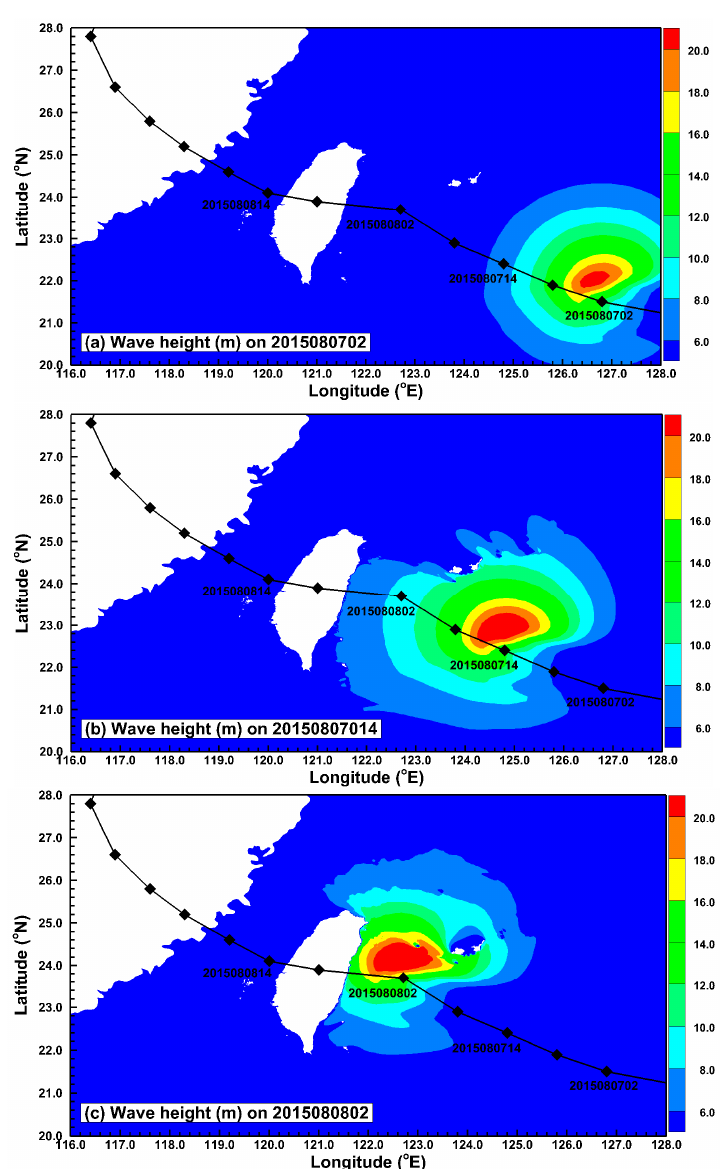
Figure 7. Spatial distribution of simulated wave height along the track of the typhoon at: ( a ) 02:00 on 7 August 2015, ( b ) 14:00 on 7 August 2015; and ( c ) 02:00 on 8 August 2015 for Typhoon Soudelor (2015).